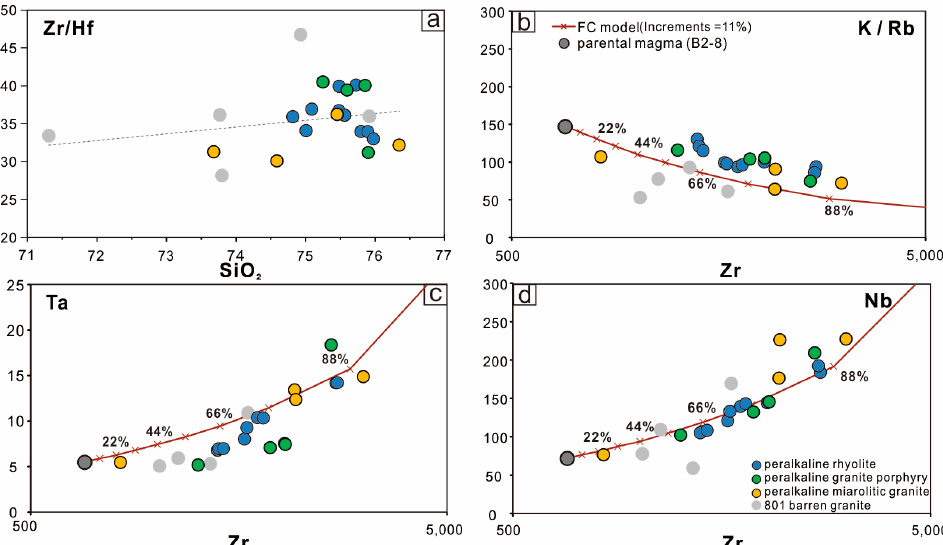
Figure 11. Diagrams of Zr/Hf versus SiO 2 and K/Rb-/Ta-/Nb versus Zr for the peralkaline granitic dikes. Rayleigh fractionation crystallization (FC) modeling results in terms of Zr versus K/Rb ratios/Ta/Nb for the peralkaline granitic dikes. The brown curved arrows in diagrams represent the predicted chemical evolution of the parental magma (B2–8) of the peralkaline granitic dikes. ( a ) Zr/Hf versus SiO 2 ; ( b ) K/Rb versus SiO 2 ; ( c ) Ta versus SiO 2 ; ( d ) Nb versus SiO 2.